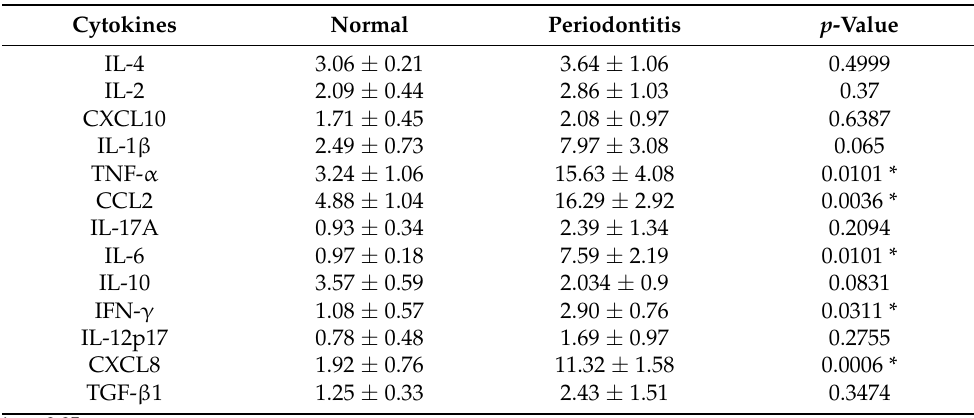
Table 2. Analysis of cytokines in the GCF from periodontitis patients (Mean ±